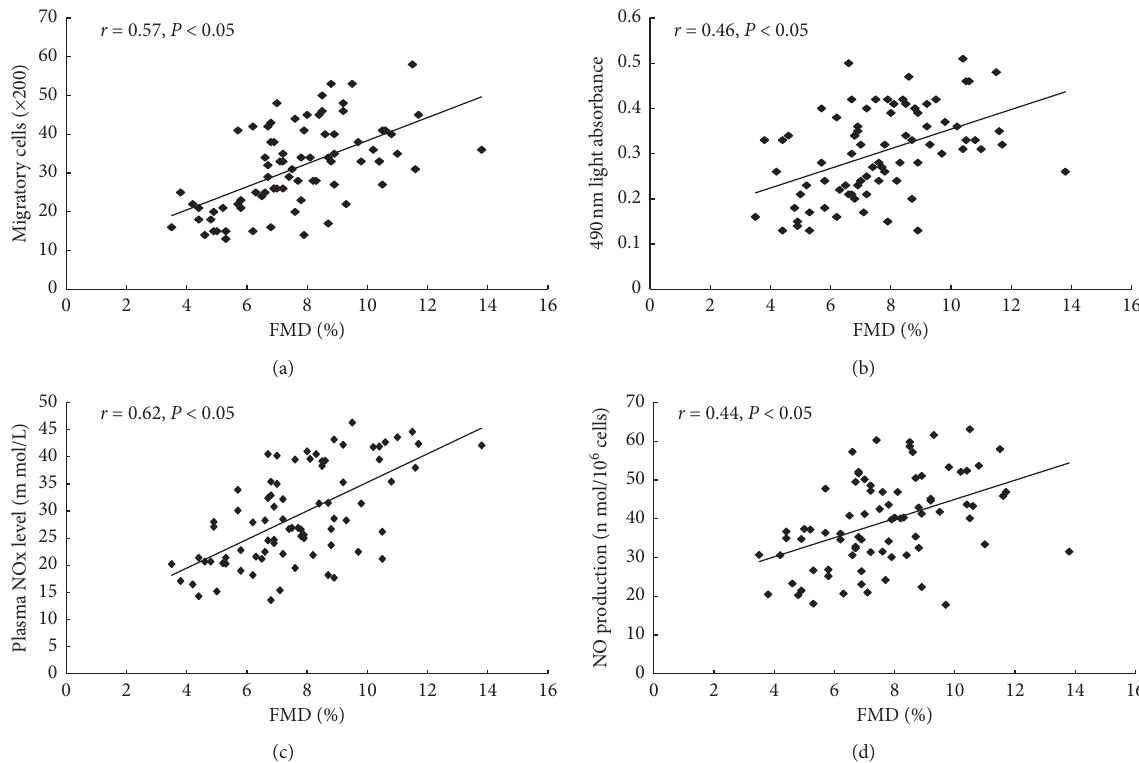
Figure 5: The correlation between FMD and EPCs or NO level. (a) and (b) There was a positive relevance between FMD and the proliferative or migratory activity of circulating ECPs. Besides, (c) and (d) FMD was positively correlated with the plasma NO level or NO level detected from cultured